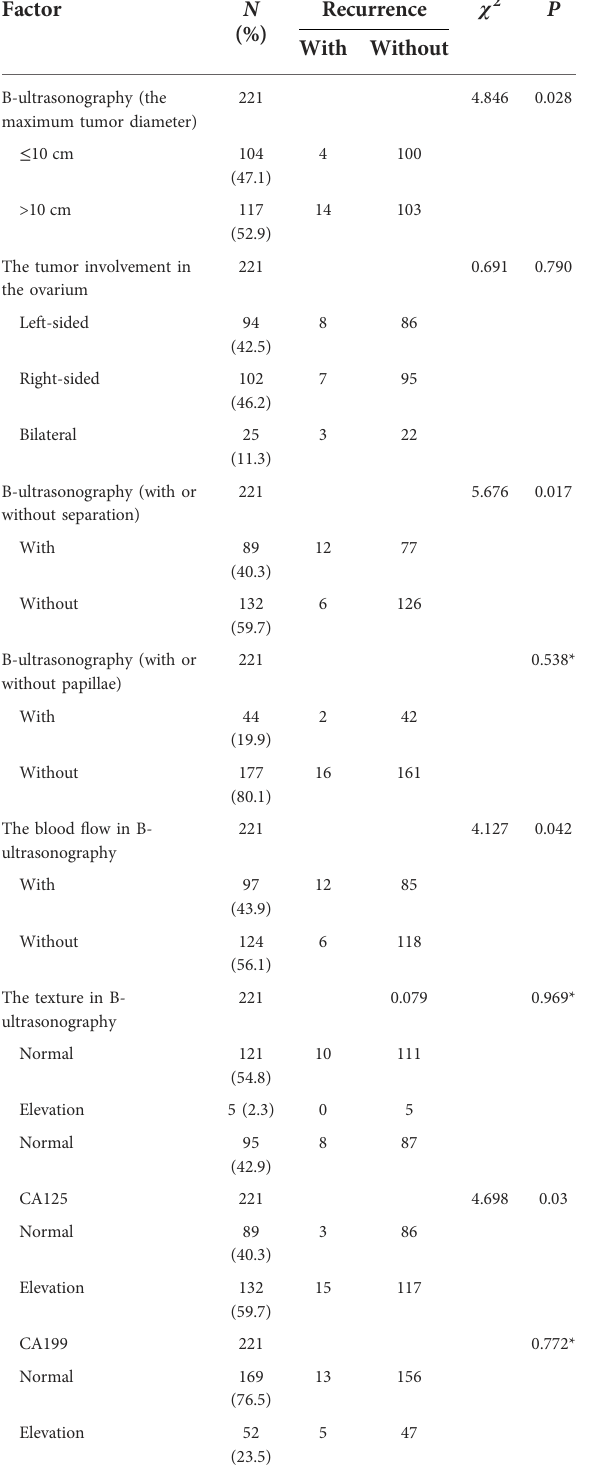
TABLE 4 The chi-square analysis of the ultrasonography characteristics, levels of CA125 and CA199 and recurrence in patients. Factor